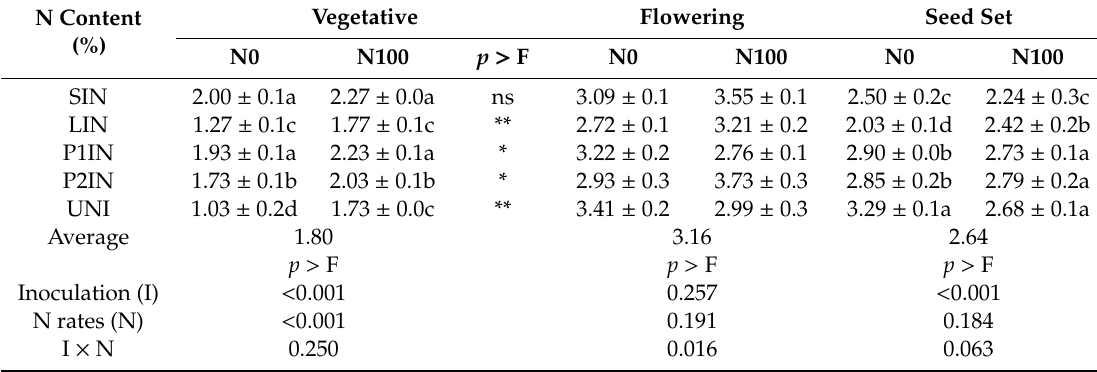
Table 3. Average ( ± standard error) nitrogen content of sulla leaves (% dry matter